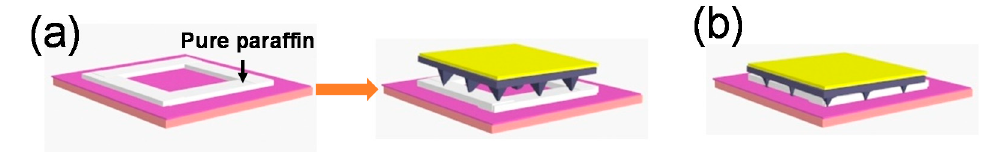
Figure 7. Schematic illustration of the air pressure sensors fabrication, ( a ) high-purity paraffin was painted on the ITO-PET layer with a closed line frame, and the conductive layer was laminated onto ITO-PET layer; ( b ) Two layers are sealed through annealing under various vacuum.